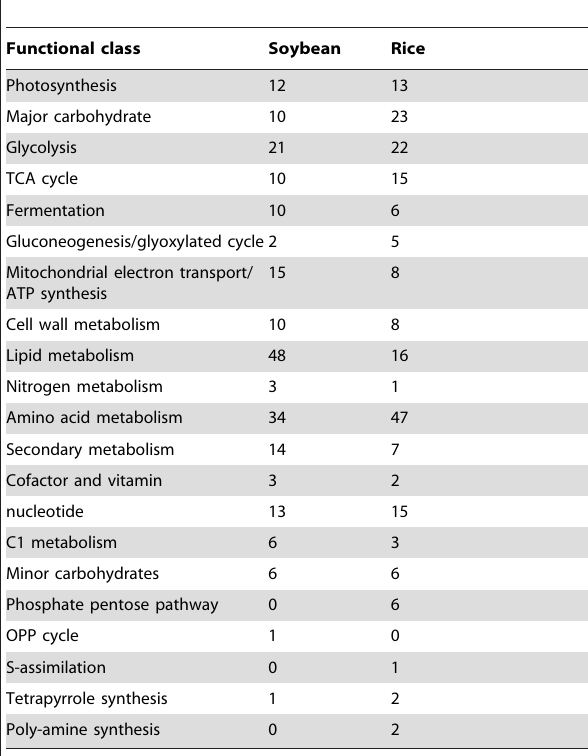
Table 1. Sub-categorization of the metabolism related proteins in germinating seeds of soybean and